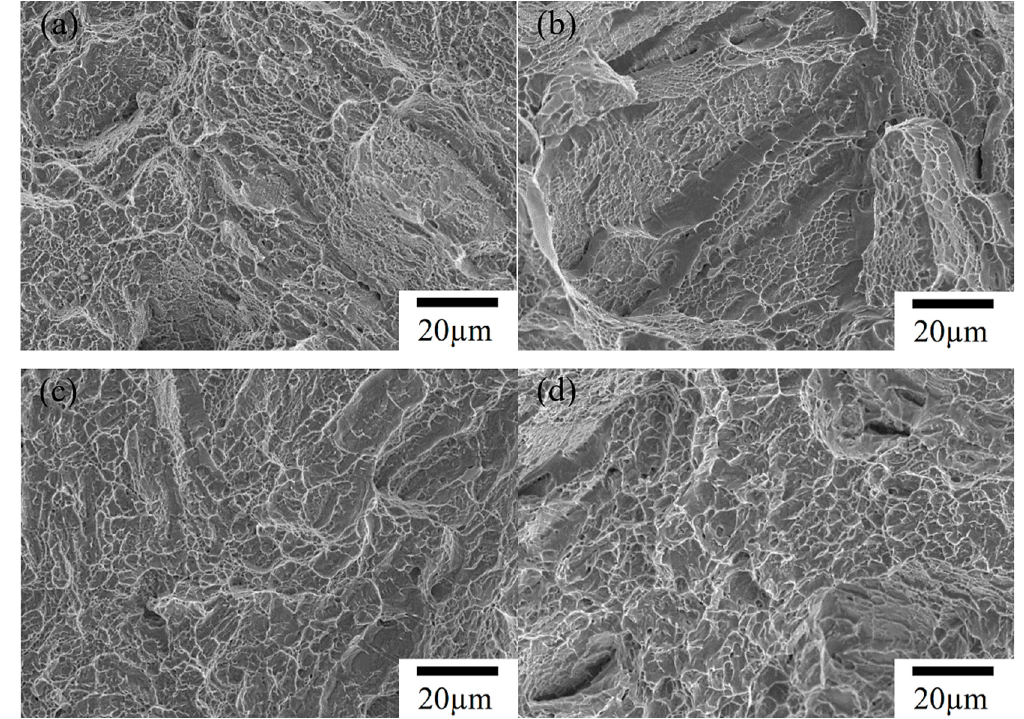
Figure 8. Morphologies of tensile fracture surfaces at room temperature for ( a ) AS, ( b ) 400-AC, ( c ) 600-AC, and ( d ) 800-AC.